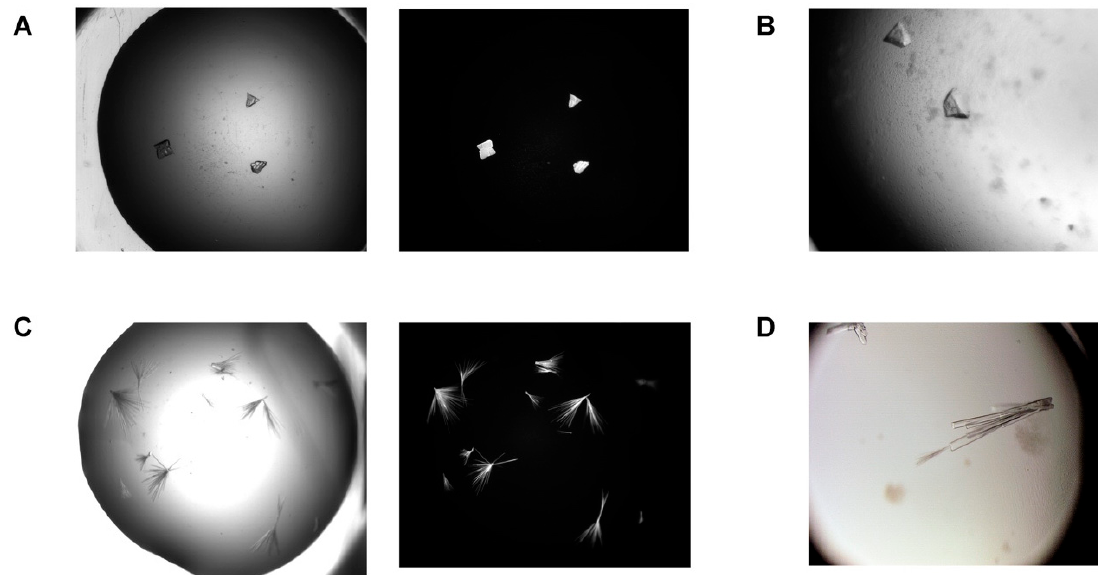
Figure 2. Crystals of the XcpVWX complex before and after optimization. ( A ) Initial hits of the chunk-like, overlapping multi-crystals of the XcpVWX complex under a bright field and UV scopes. The complex was subjected to a low-dosage and shorter digestion of chymotrypsin (CT). ( B ) Optimized chunk-like crystals under bright field. Crystals became larger in size after microseeding. ( C ) Initial crystal hits of the needle clusters of the XcpVWX complex under bright field and UV scopes using high-quantity and longer digestion of CT. ( D ) Optimized needle clusters of crystals under a bright field. This type of crystal not only grew in size, but also formed well-shaped three-dimensional clusters of rod-like crystals.